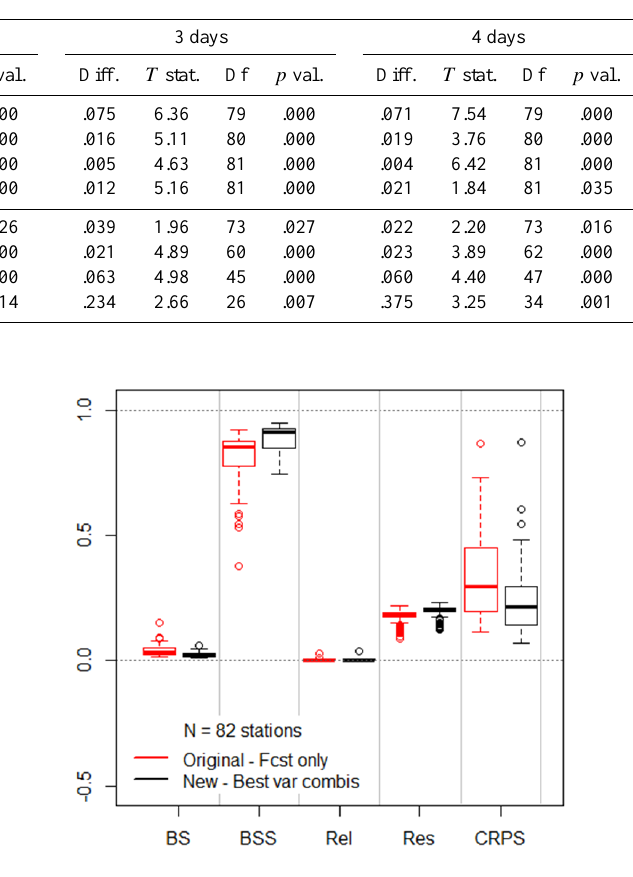
Figure 17. Comparison of the forecast-only QR configuration (i.e., only transformed forecast as independent variables) and us- ing the best-performing joint predictor at each gauge along vari- ous measures of forecast quality: BS, BSS, reliability (Rel), resolu- tion (Res), and CRPS. Lead time of 3 days and 75th percentile of observation levels as